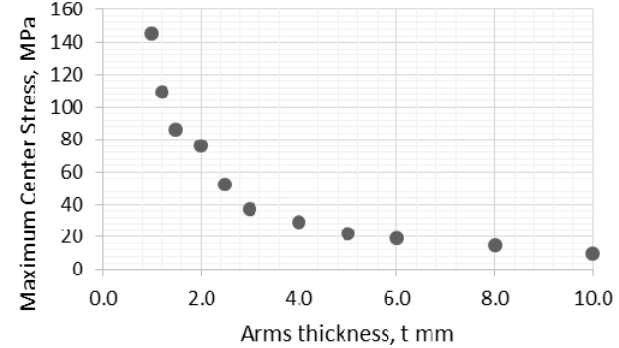
Figure 9: Maximum center stress, Load Case